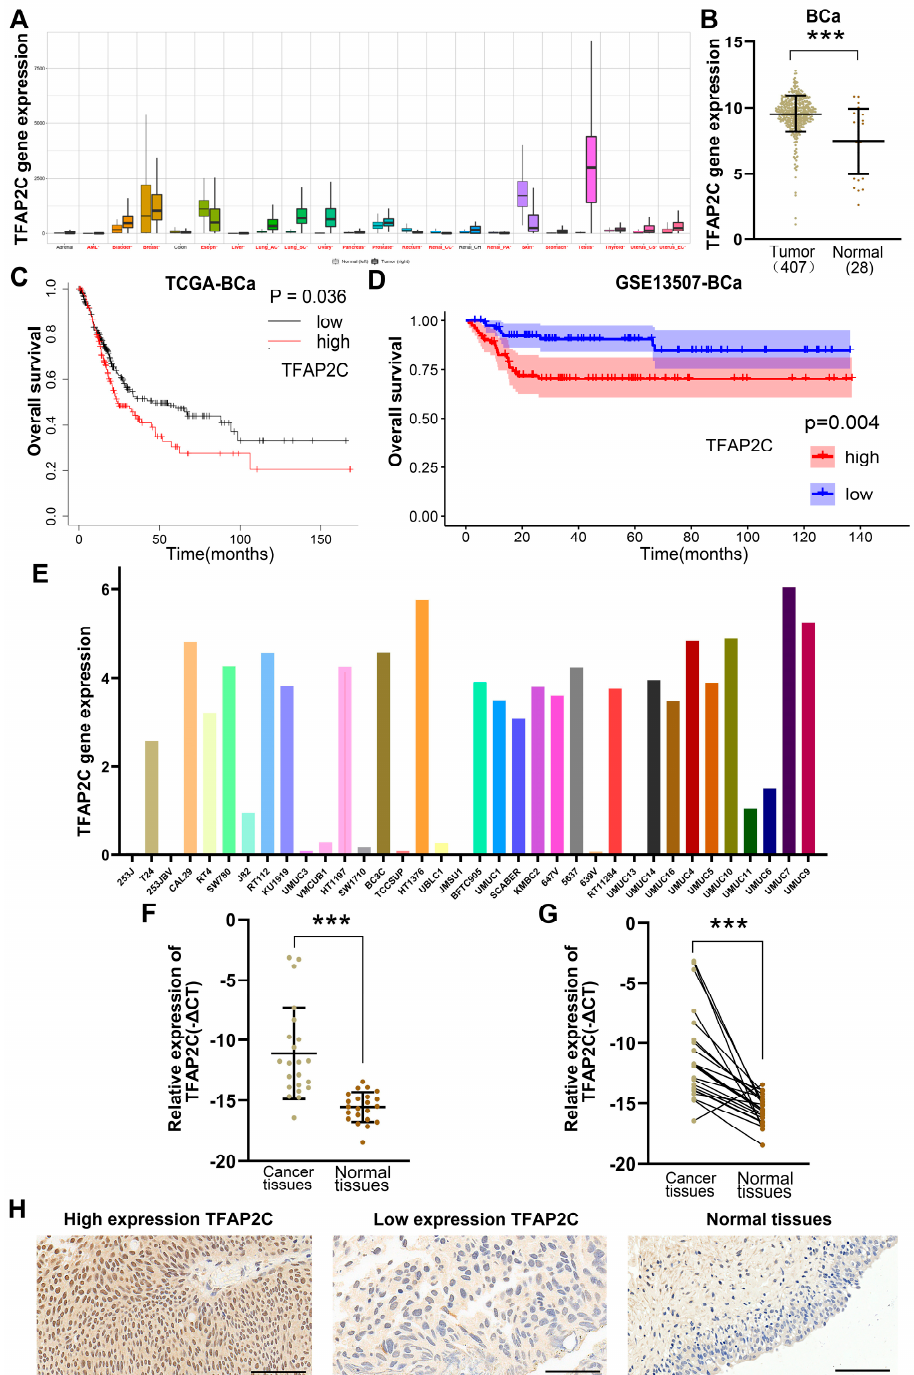
Figure 1. TFAP2C expression analysis and cancer prognosis. ( A ) The expression of TFAP2C in pan − carcinoma tissues. Tumor names marked in red represent significant differences. ( B ) TFAP2C expression in tumor and normal tissues in TCGA − BLCA dataset and GTEx datasets. ( C , D ) Kaplan − Meier plot curves of the TCGA − BLCA dataset ( C ) and GSE dataset (GSE13507) ( D ). ( E ) The expression of TFAP2C in 36 BCa cell lines. ( F , G ) qRT − PCR was performed to measure TFAP2C mRNA expression levels in 22 pairs of BCa and adjacent normal tissues. TFAP2C expression was significantly upregulated in BCa tissues compared with adjacent normal tissues. ( H ) Representative immunohistochemistry of TFAP2C in BCa tissues and adjacent tissues. Scale bars, 100 µm. (*** p < 0.001, ns, not significant).